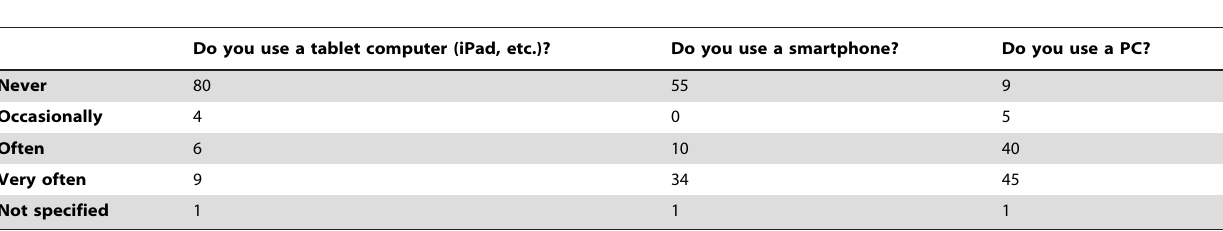
Table 1. Experience of the participants with a personal computer (PC) and touchscreen operated devices (n =